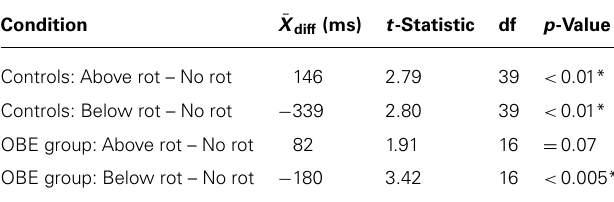
Table 1 | Breakdown of the separate effects ofViewpoint and Rotation within the two